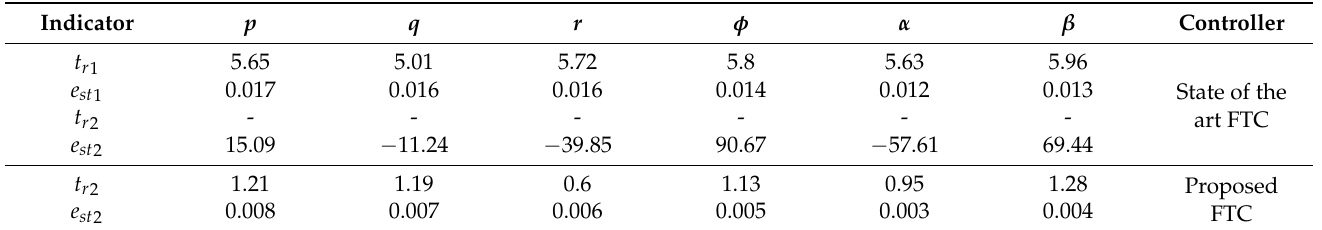
Table 1. Tracking performance comparison between state-of-the-art FTC in reference [17] and pro- posed